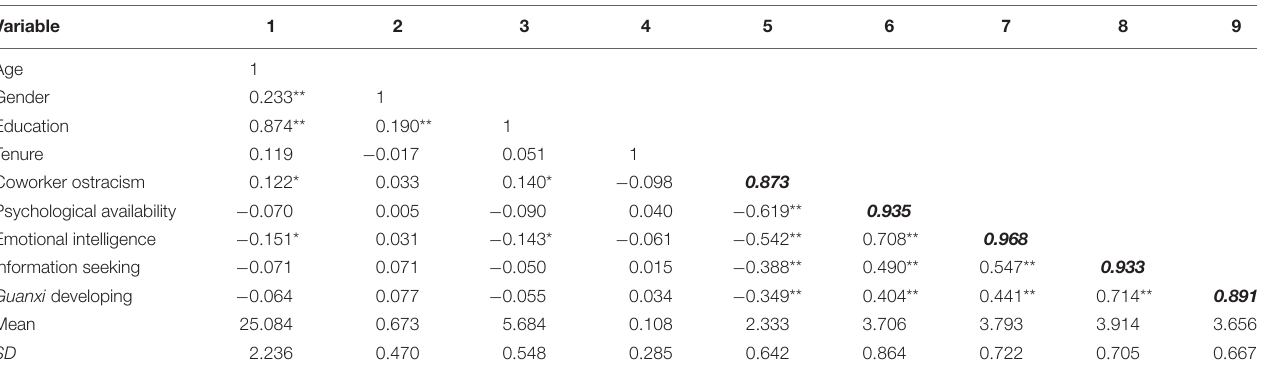
TABLE 2 | Means, standard deviations, reliabilities, and correlations.